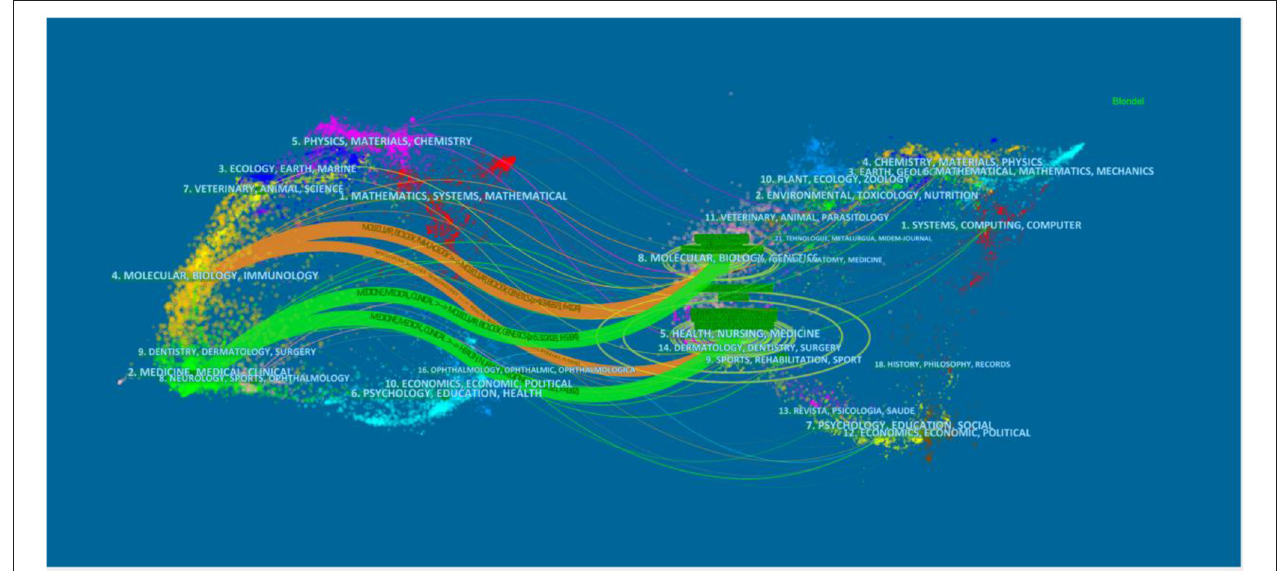
FIGURE 5 | Dual-map overlay of journals related to AG research.